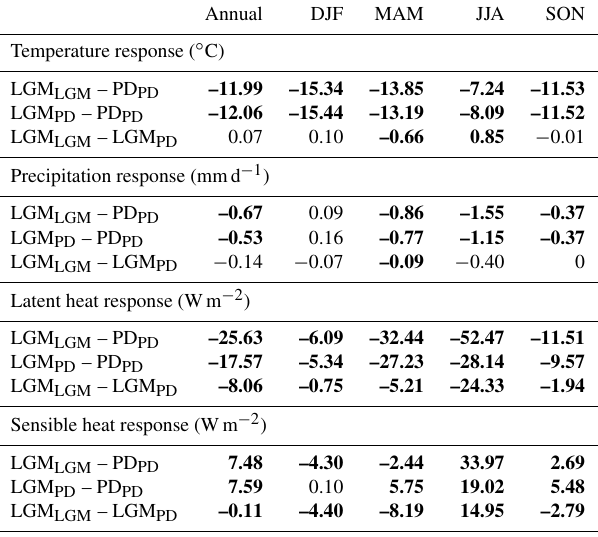
Table 3. Assessment of the atmospheric response using 30 years of simulated precipitation and temperature data. First column indicates the simulations, second column the annual response, and the other columns the response in each season. Numbers in bold represent statistically significant differences using a two-tailed bootstrapping and a significance level of 2%. Note that the assessment considers land areas without snow/ice that are shared by both LGM and PD climate and discards the continental shelves exposed at the